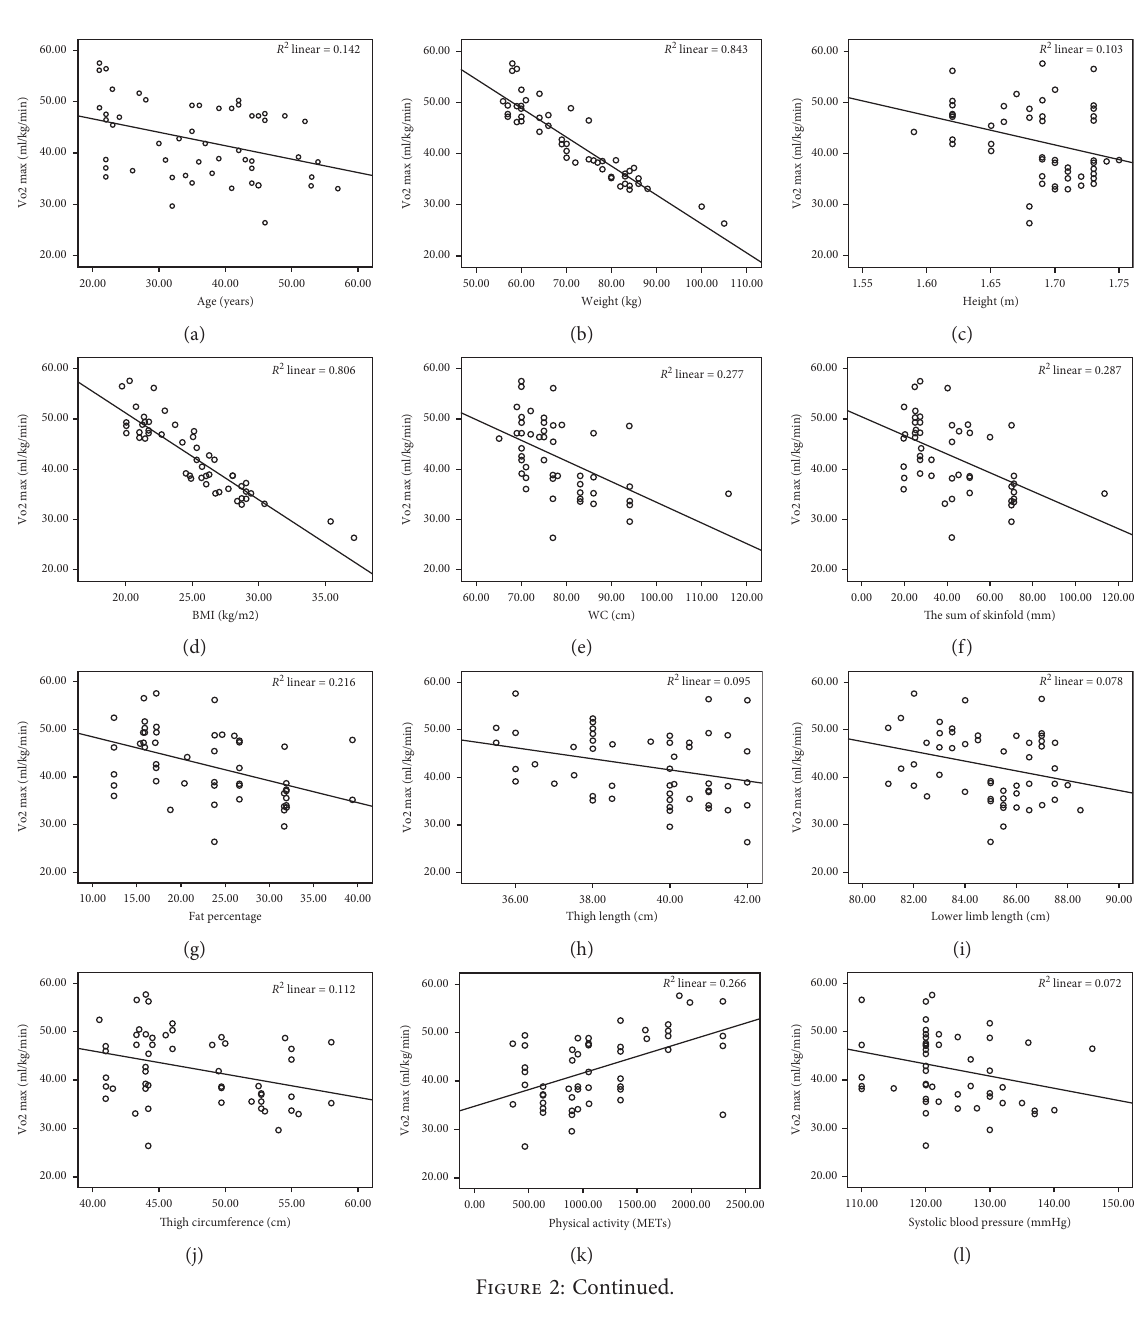
Table 3: A multivariate model of association of the estimated VO